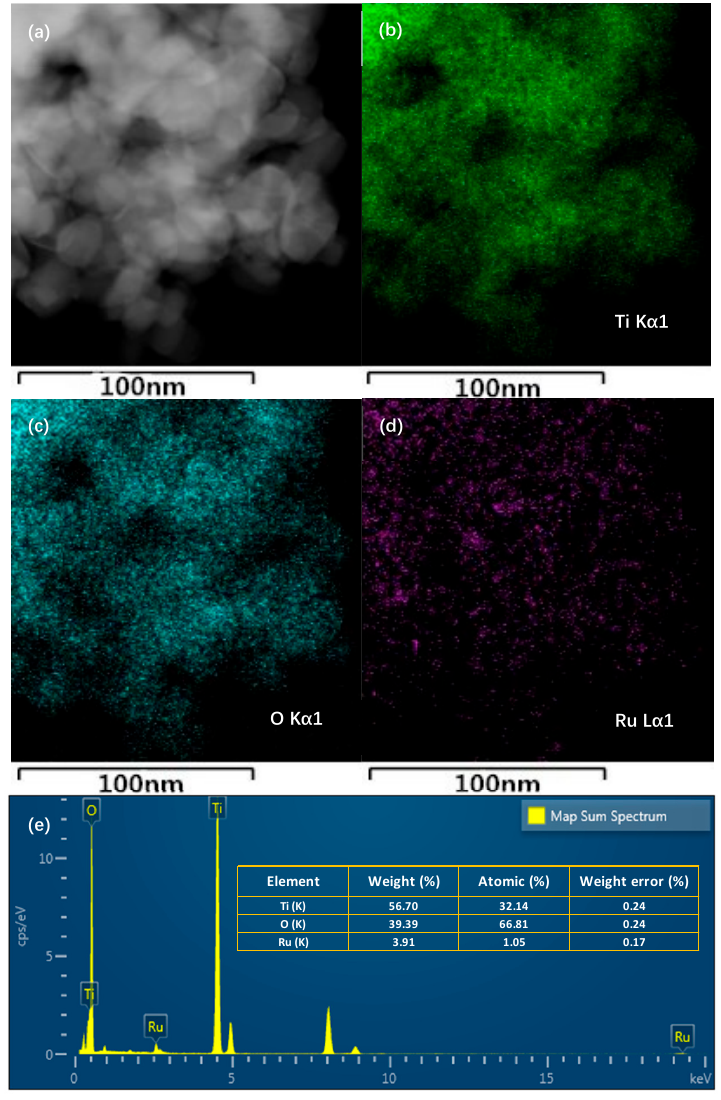
Figure 4. TEM-EDX elemental mapping of RuO 2 /TiO 2 -r: ( a ) representative TEM image, ( b ) Ti (K α 1) green color, ( c ) O (K α 1) blue color, ( d ) Ru (L α 1) pink color, and ( e ) EDX (Energy-dispersive X-ray) result of the selected area.